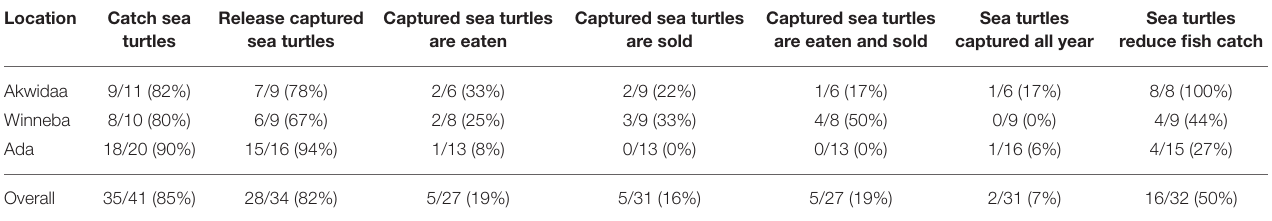
TABLE 3 | Frequency of fishers that reported capturing different species of sea turtles in the artisanal fishery. Location Leatherback Olive Ridley Green Loggerhead